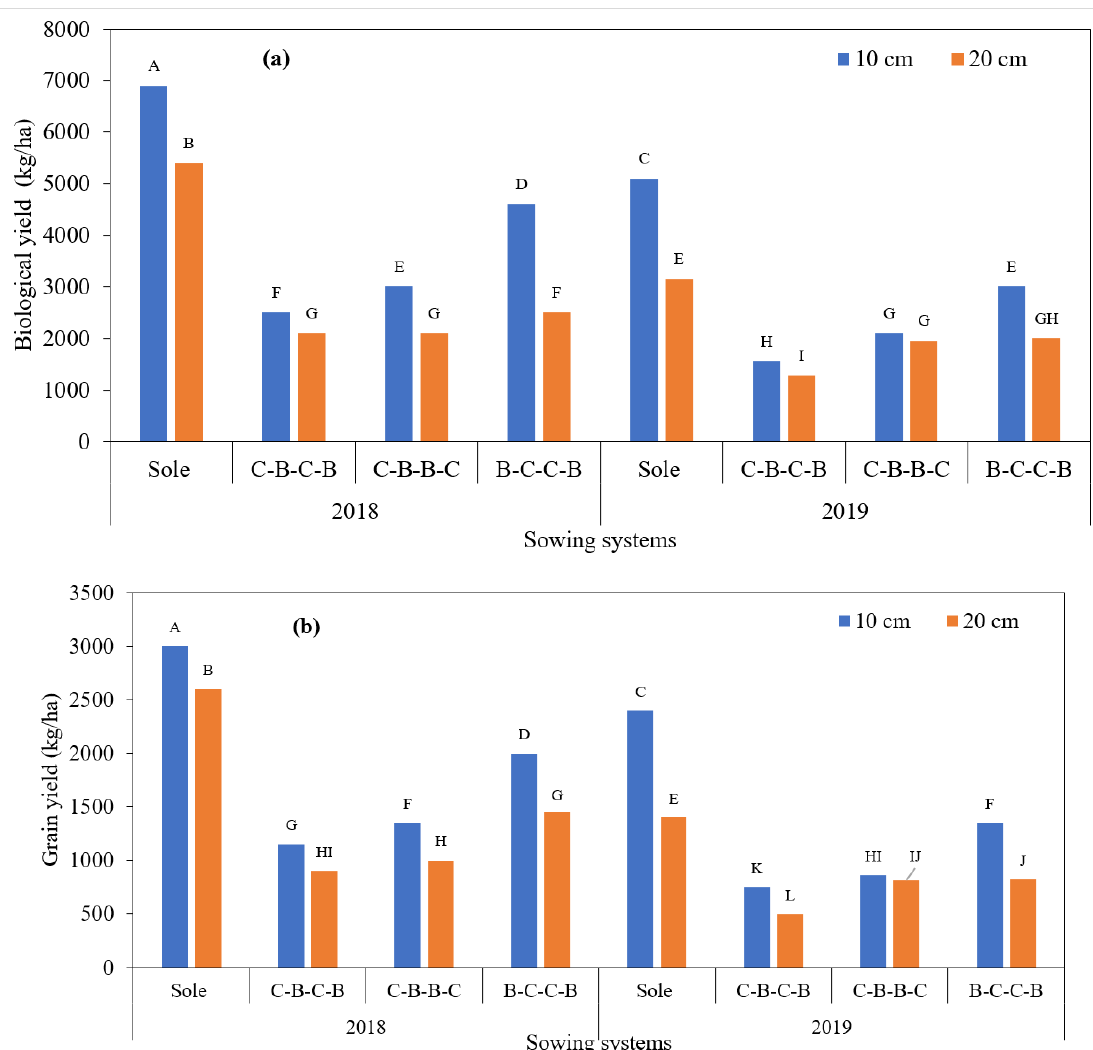
Figure 7. The interactions of maize–white bean sowing systems on biological yield ( a ) and grain yield ( b ) at Nur Sultan, Kazakhstan research station. Letters on each bar represent significance level at p < 0.01. Note: different letters denote significant differences, while the same letters indicate insignificantly different values.